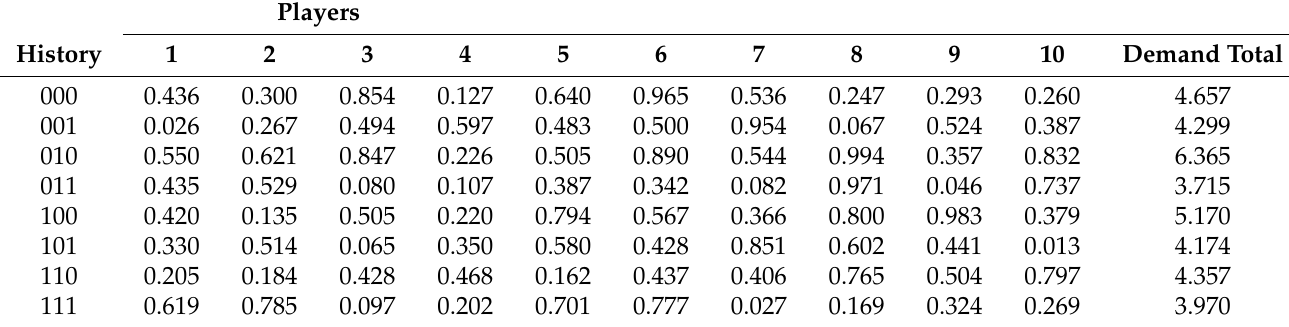
Table 2. demands at generation 0.